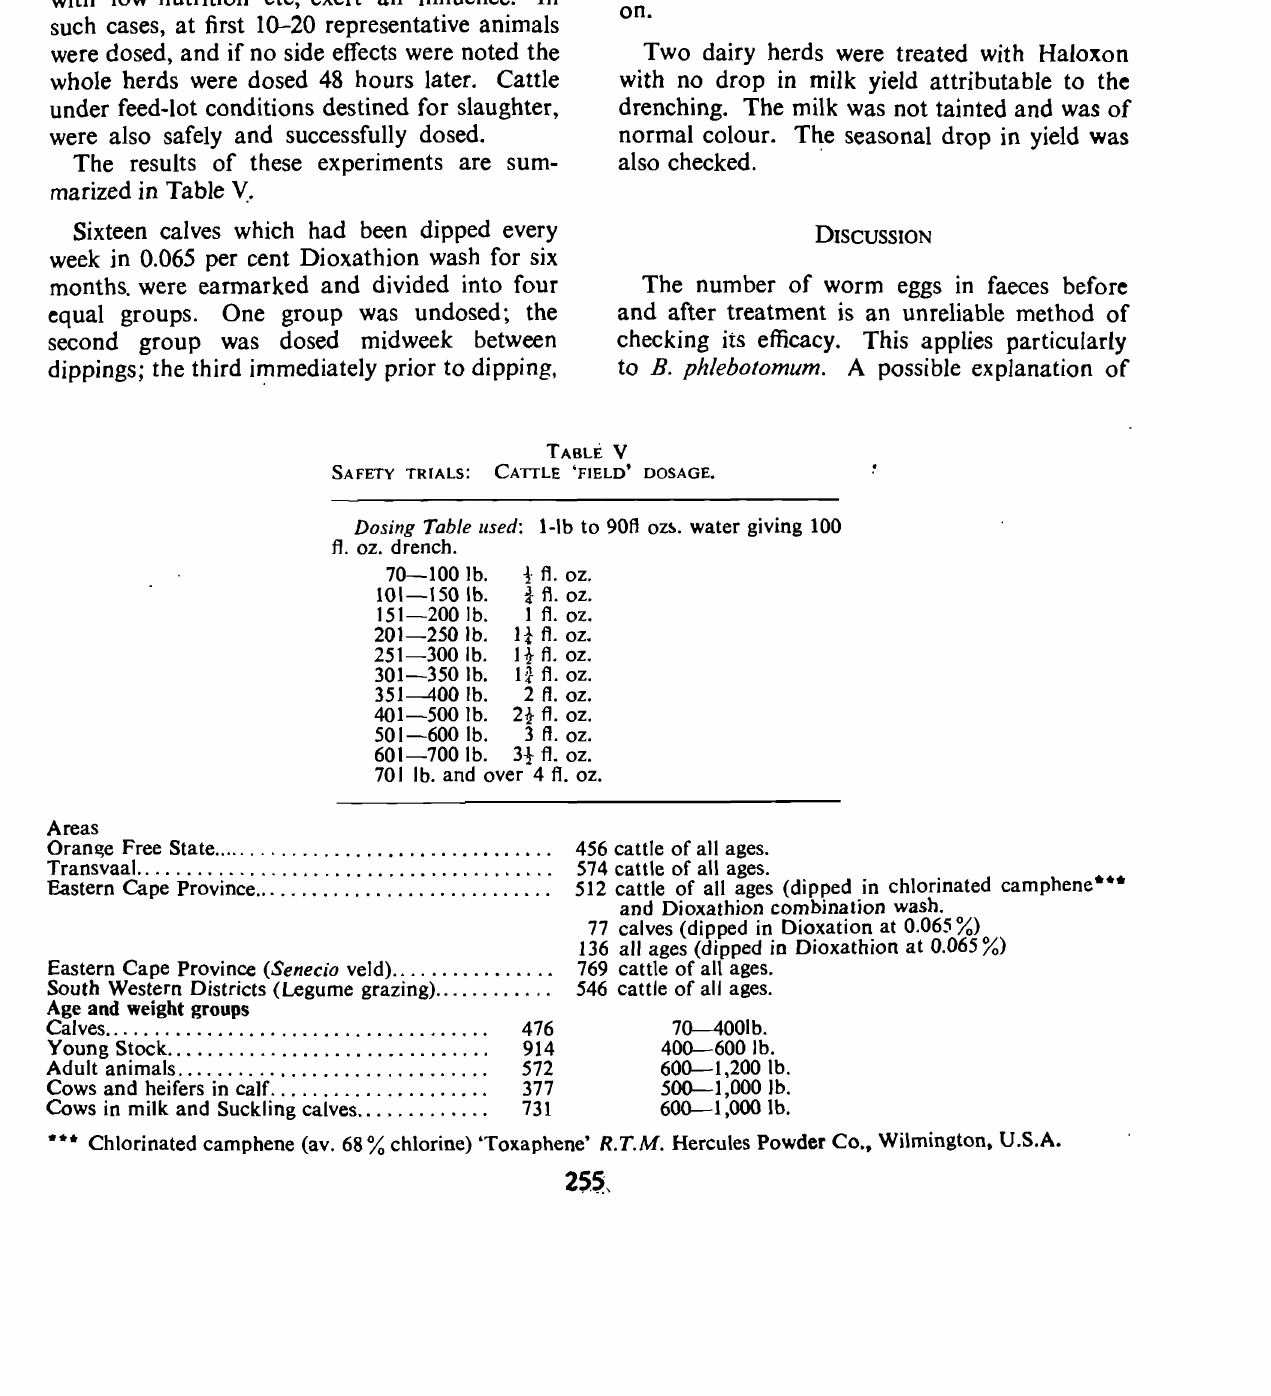
SAFETY TRIALS: CATTLE 'FIELD'